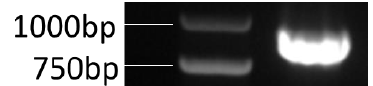
Figure 3. PCR results of the target genes